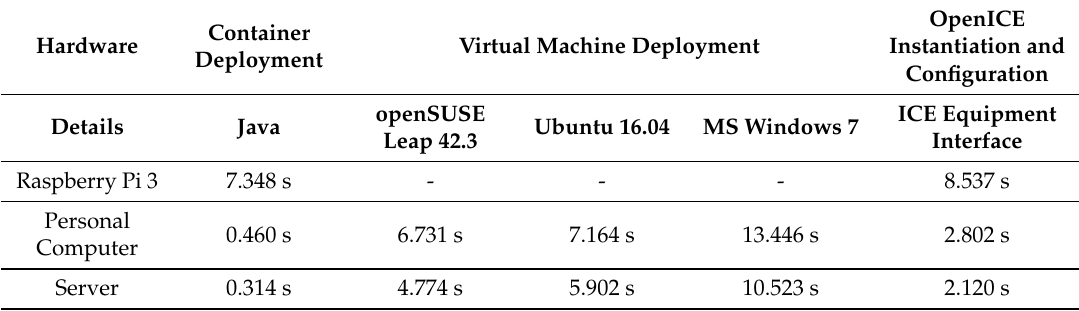
Table 8. Deployment time of a new ICE Equipment Interface with a virtual medical